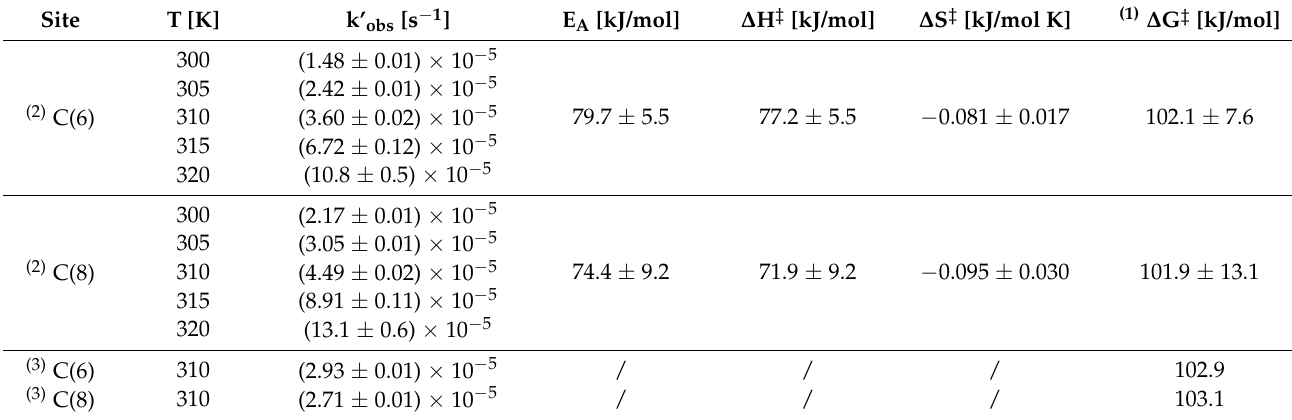
Table 1. Kinetic data for deuterium ion incorporation process by heavy water (D 2 O) on catechin and epicatechin substrates. The values of Gibbs free energy of activation (∆G ‡ ) in the case of epicatechin are theoretically calculated based on a given temperature by the Eyring equation, as the qualitative contribution division into enthalpy and entropy of activations.